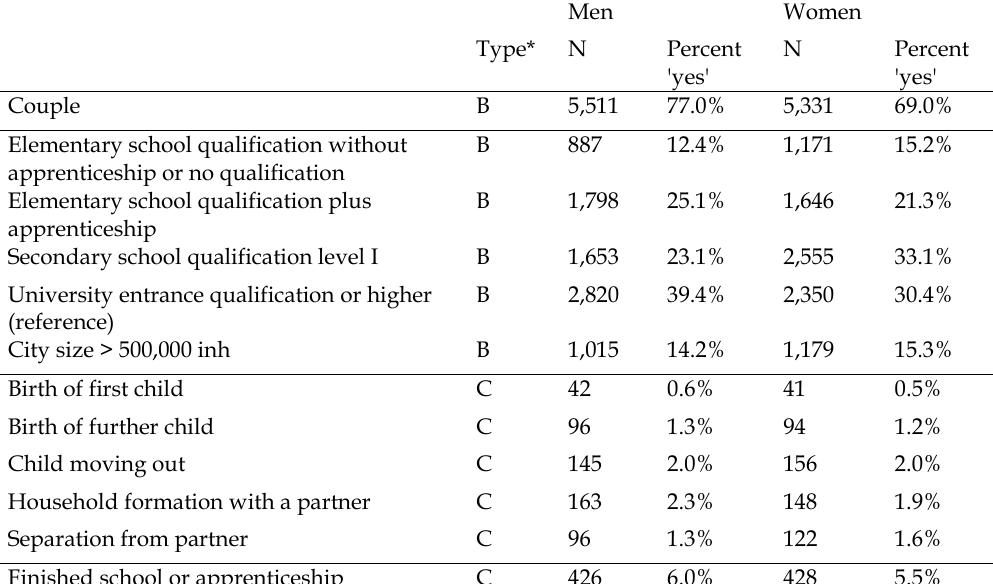
Table 2. Dummy variables used in regression: descriptive